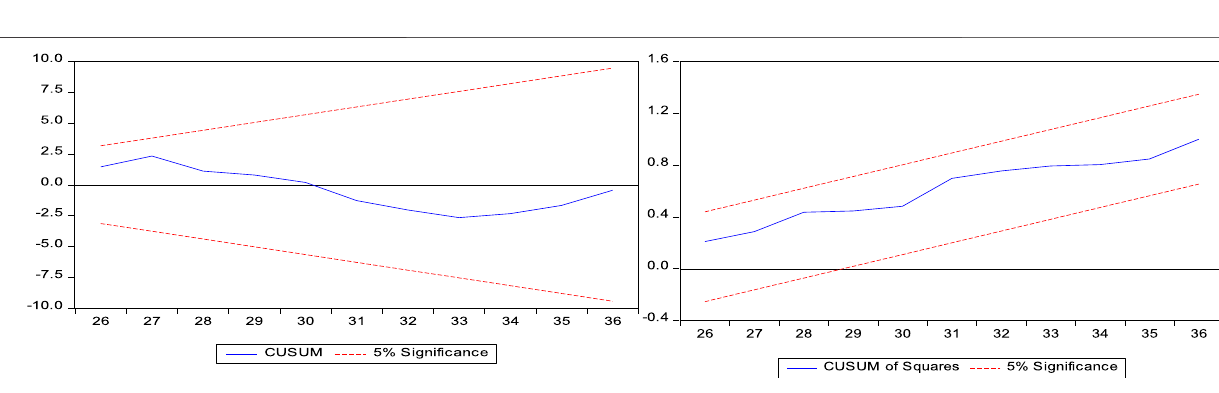
Frontiers in Energy Research |